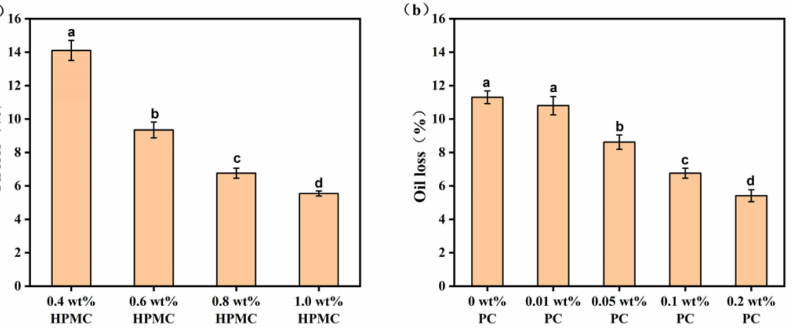
Figure 7. Oil loss of oleogels prepared by different HPMC concentrations and a constant PC concen- tration (0.1 wt%) ( a ). Oil loss of oleogels prepared with different PC concentrations and a constant HPMC concentration (0.8 wt%) ( b ). Letters a–d indicate significant difference in different oleogels